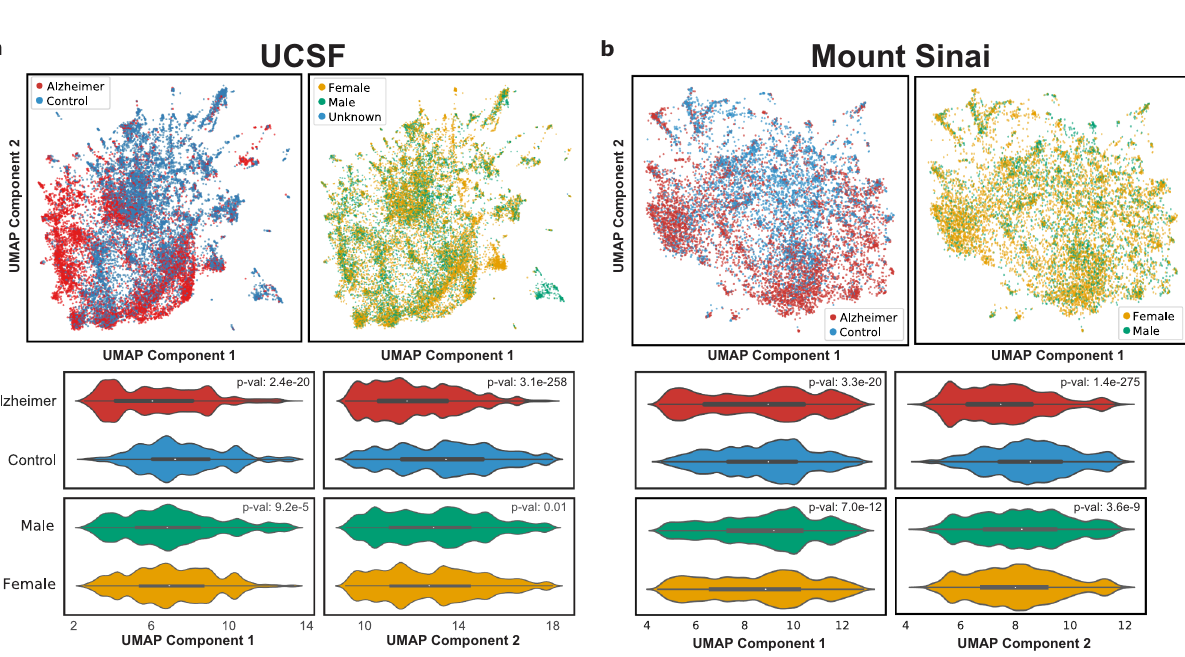
Fig. 2 UMAPs using comorbidities as features provide a topographical view of the distribution of patients. Top row: UMAP of all patients (AD and controls), with each dot representing a patient, colored by AD status ( a top left, b top left) or by sex ( a top right, b top right). Middle and bottom rows: violin plots show the distribution of patients with AD and controls along the UMAP principal components for UCSF ( a ) and Mount Sinai ( b ), and p -values determined from comparing distributions with a two-sided Mann – Whitney U -test. Alzheimer vs Control: UCSF p -value 2.4e − 20 (component 1) and 3.1e −